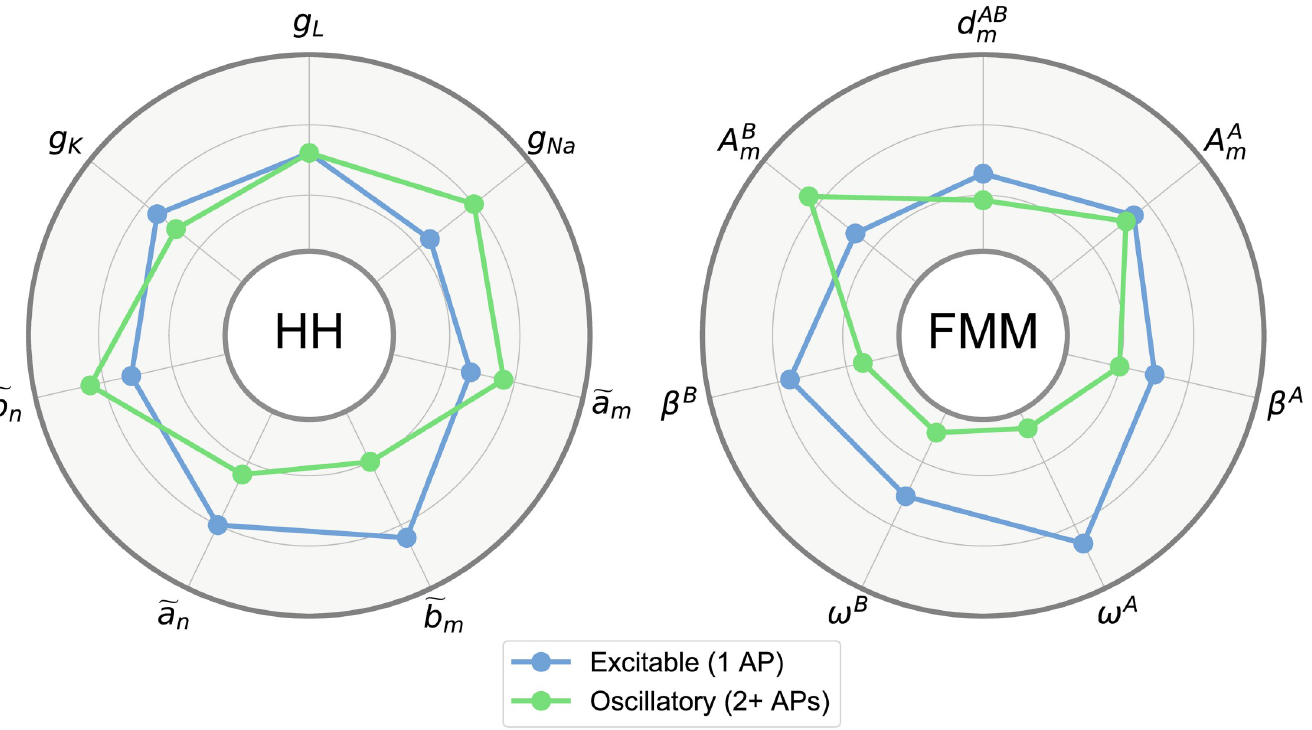
Fig 4. Median values of the HH parameters and FMM ST parameters (defined in Table 3) by neuron type. The represented interval for each parameter is between the 10% and 90% percentiles.